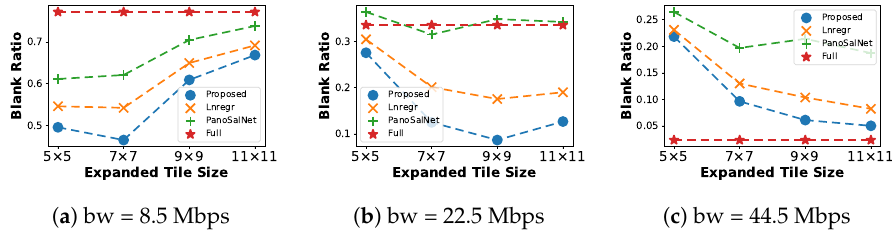
Figure 6. Average Blank Ratio for different head prediction models under different bandwidth conditions.